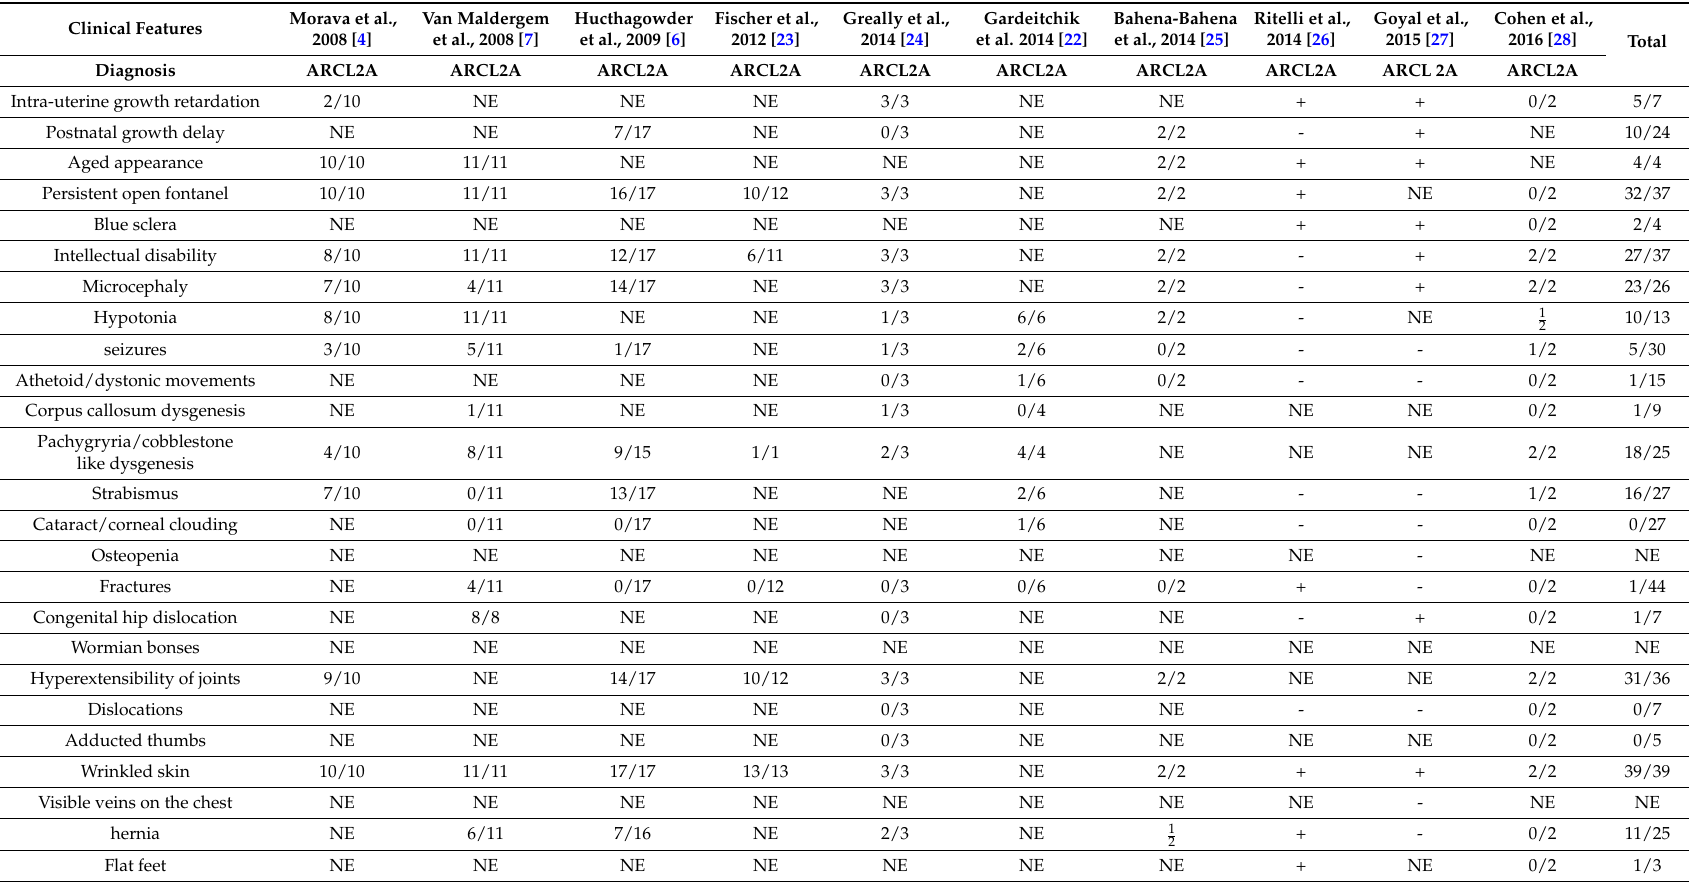
Table A1. Clinical features in autosomal recessive cutis laxa 2A patients reported in the